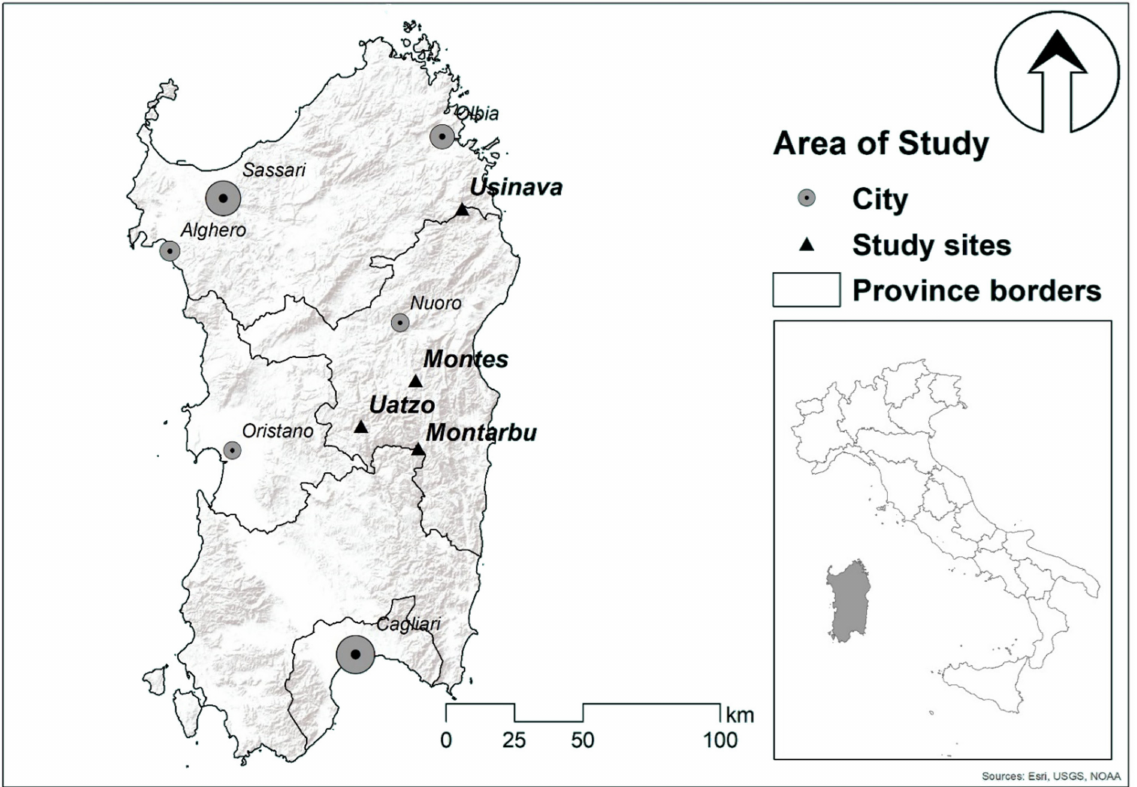
Figure 1. Location of the four common gardens in